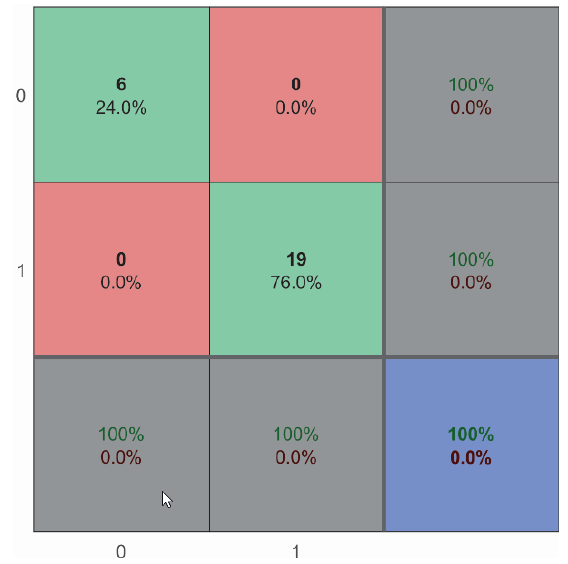
Figure 6. Confusion matrix, where 0 is circular and 1 is lineal polarization. 255